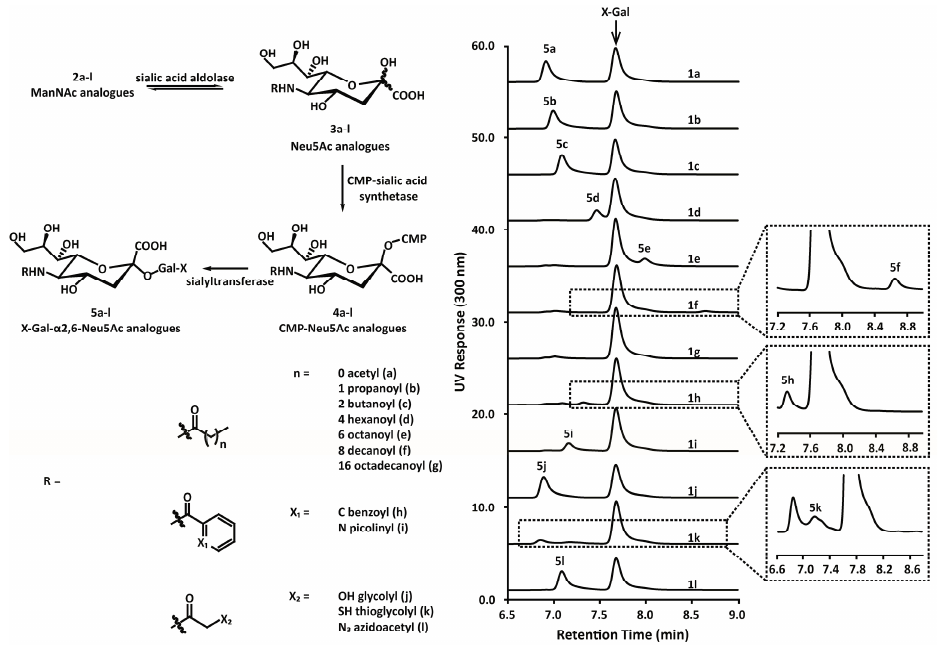
Figure 2. Reaction scheme of the synthesis route of X-gal sialosides. 2a–l was achieved by PhGn2E using 1a – l as substrates. The resulting X-gal sialosides ( 5a , 5b , 5c , 5d , 5e , 5f , 5h , 5i , 5j , 5k and 5l ) were synthesized by a four-enzyme reaction starting with N -acetylglucosamine ( 1a ); N -propanoylglucosamine ( 1b ); N -butanoyl- glucosamine ( 1c ); N -hexanoylglucosamine ( 1d ); N -octanoylglucosamine ( 1e ); N -decanoylglucosamine ( 1f ); N -benzonylglucosamine ( 1h ); N -picolinylglucosamine ( 1i ); N -glycolylglucosamine ( 1j ); N -thioglycolylgluco- samine ( 1k ) and N -azidoacetylglucosamine ( 1l ) as initial substrates with relative conversion rates of 37%, 33%, 37%, 15%, 16%, 2.3%, 3.1%, 13%, 39%, 3.2%, and 38%, respectively. No yield from 1g was observed to obtain 5g